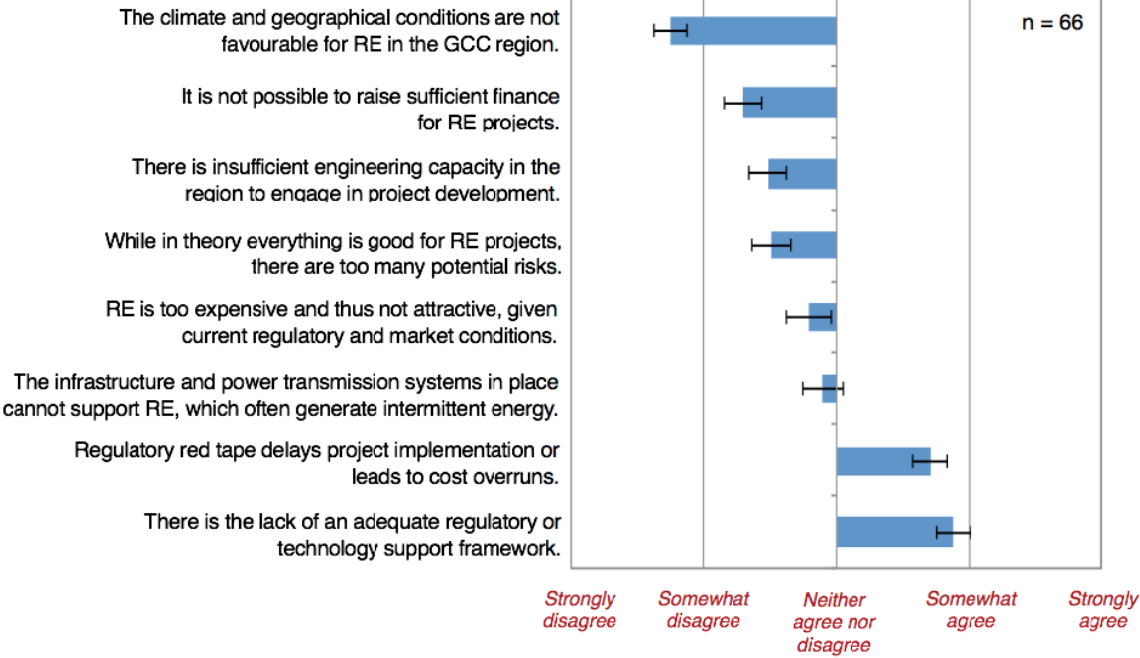
Figure 3. Results of question 2—the most challenging barriers to scale up renewables in the GCC